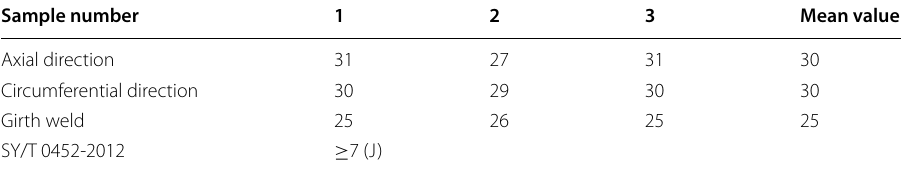
Table 9 Impact performance test